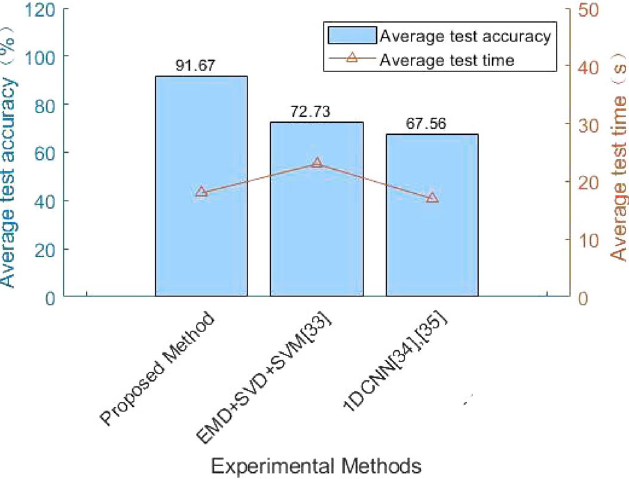
Figure 13. Comparison of the proposed method with other methods in the